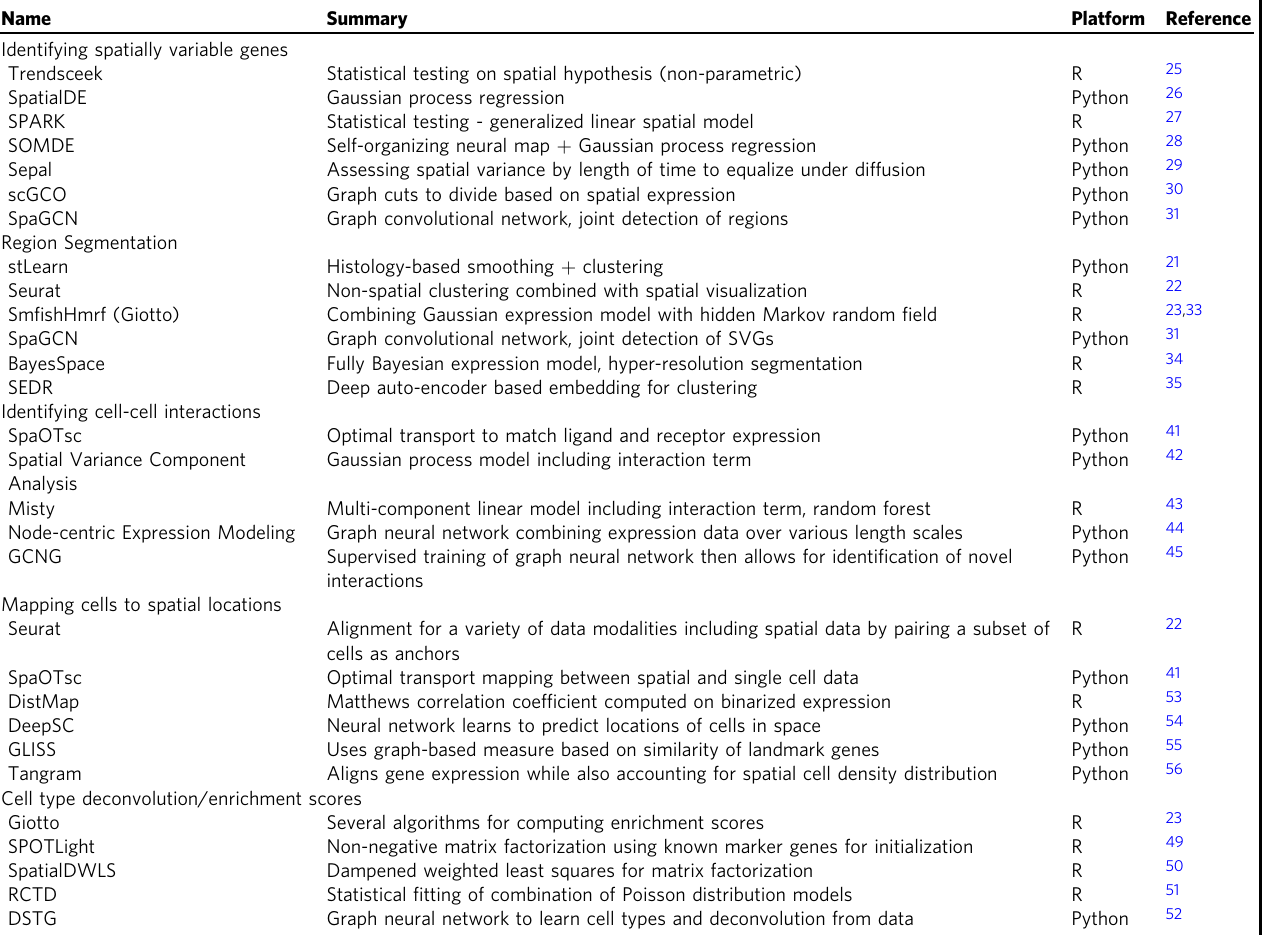
Table 1 List of software